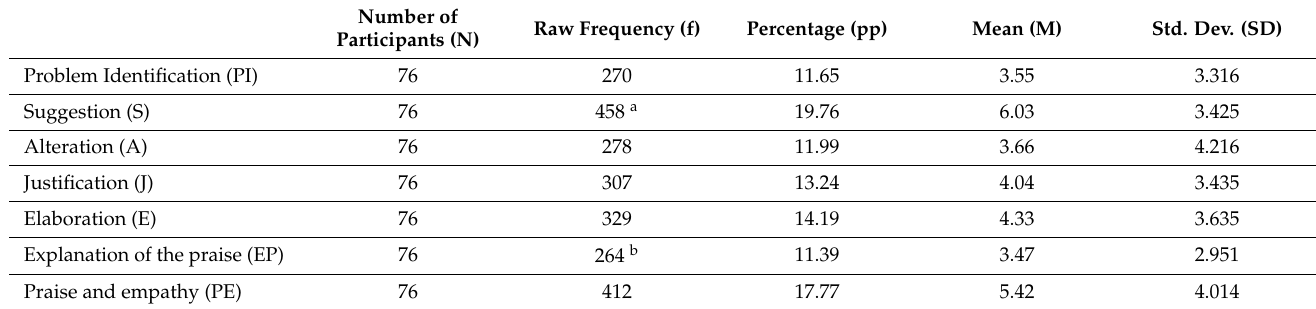
Table 1. Descriptive statistics for the different types of feedback